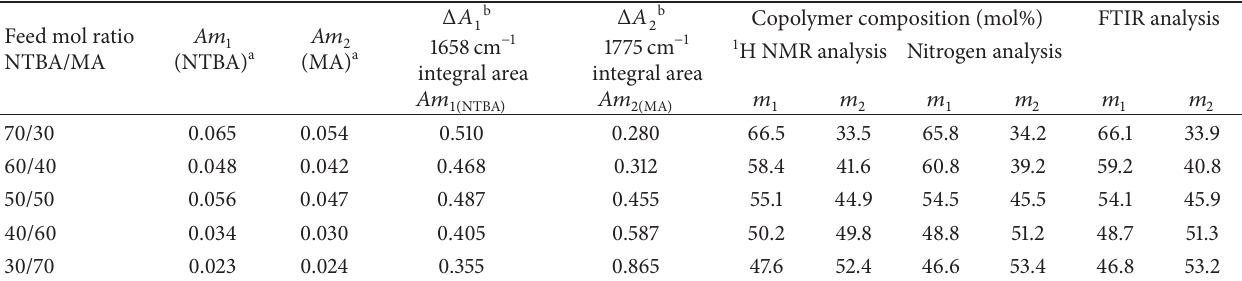
Table 1: 1 H NMR, FTIR, and elemental analysis of NTBA/MA copolymers synthesized from various monomers feed ratio.